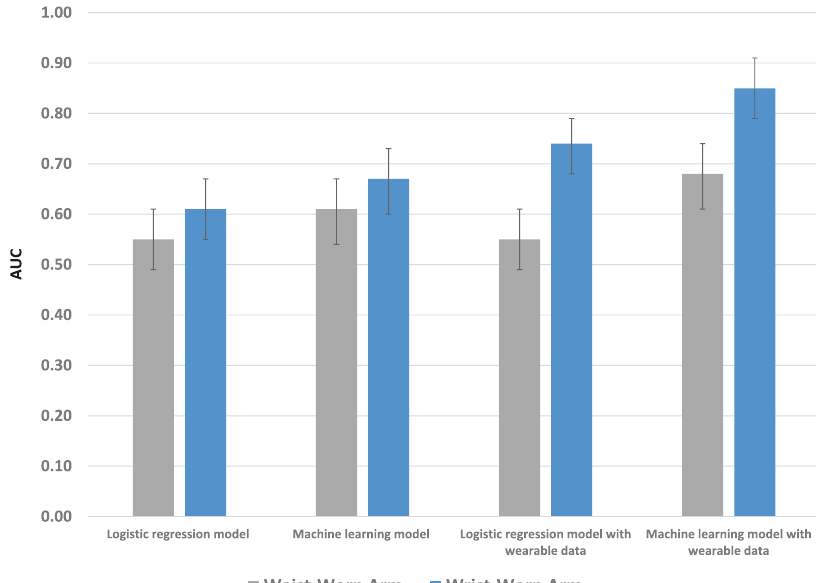
Fig. 3 Prediction of hemoglobin A1c worsening. Represents prediction for an increase in hemoglobin A1c of ≥ 0.3. Displayed by type of model (logistic regression or ensemble machine learning), use of data (with or without wearable data), and type of wearable (waist or wrist). Data presented are Area Under the Curve (AUC) and 95% con fi dence intervals from the testing